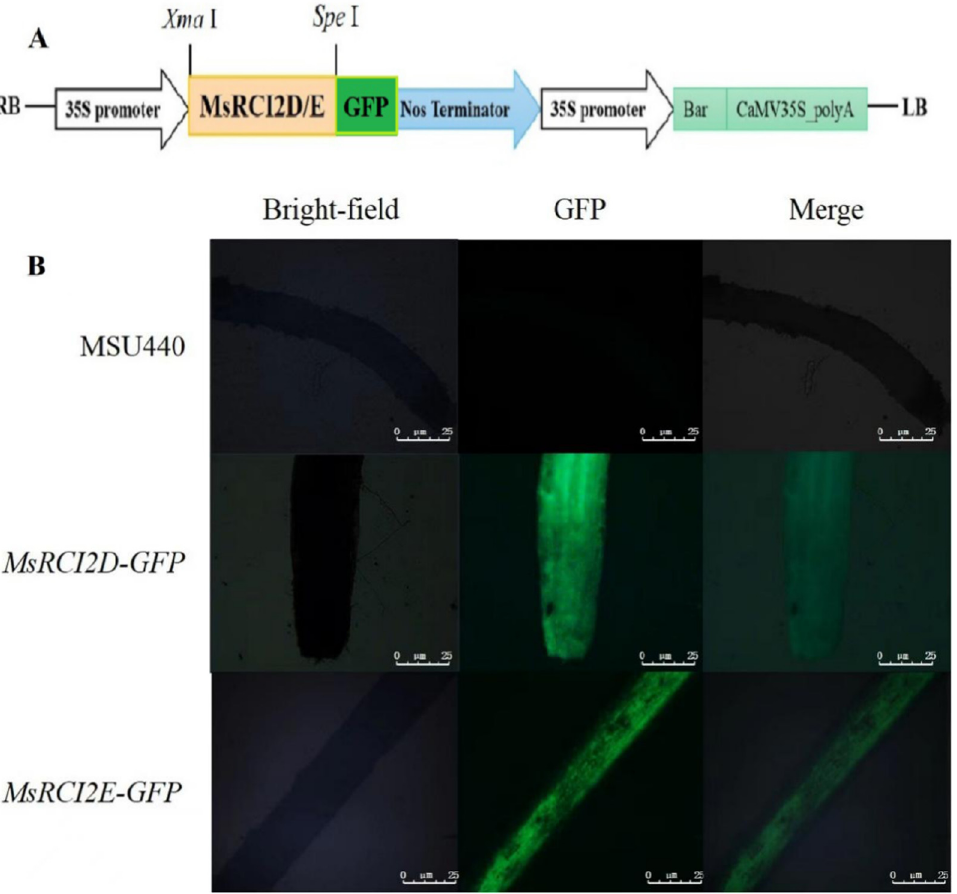
Figure 3. Transgenic alfalfa chimera overexpressing MsRCI2D–GFP or MsRCI2E–GFP in hairy roots due to Agrobacterium rhizogenes. ( A ) Vector structure; ( B ) green-fluorescent-signal detection in MsRCI2D/-E transgenic hairy roots. Confocal laser scanning microscope images of MsRCI2D- and -E–GFP -overexpressing transgenic alfalfa chimera. White scale bars represent 25 µm.